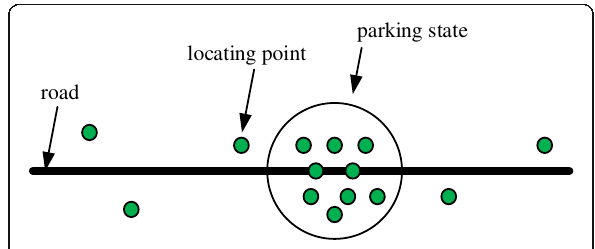
node, and link relationship between section and section. Figure 3 is a simple road network, including four paths: R1, R2, R3, and R4. These paths are divided by nodes into eight sections, sections A, B, C, D, E, F, G, and H, where the purple dot presents the road intersection node, and the blue dot presents the shape point in the